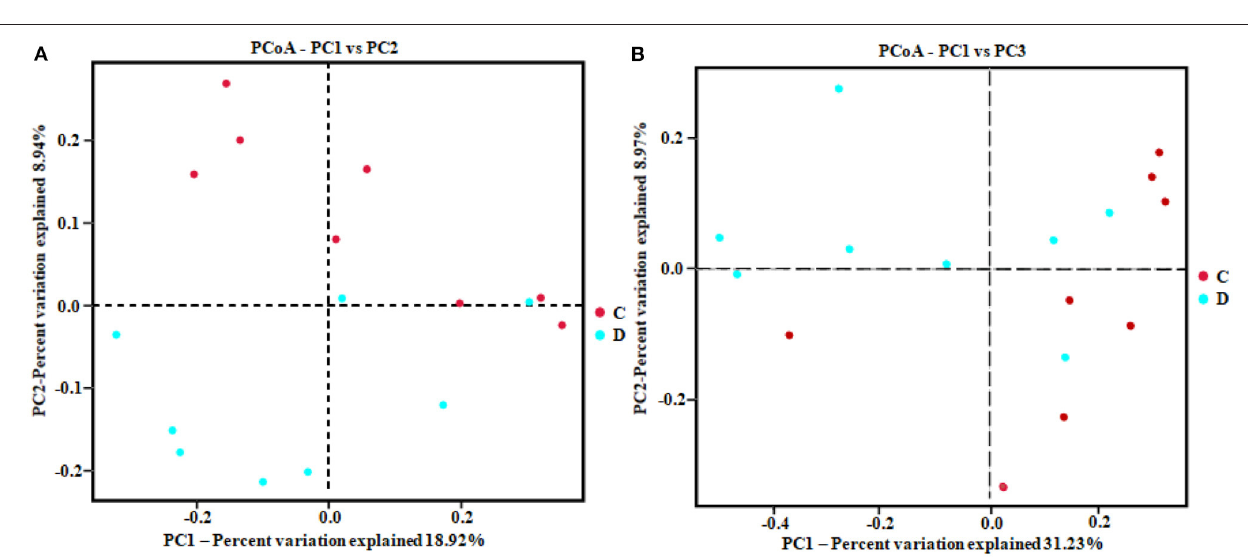
FIGURE 3 | Principal coordinates analysis (PCoA) diagram of heterogeneity between the two groups. Scatterplot from PCoA based on binary-Jaccard (A) and Bray–Curtis dissimilarity (B) in gut fungal community.